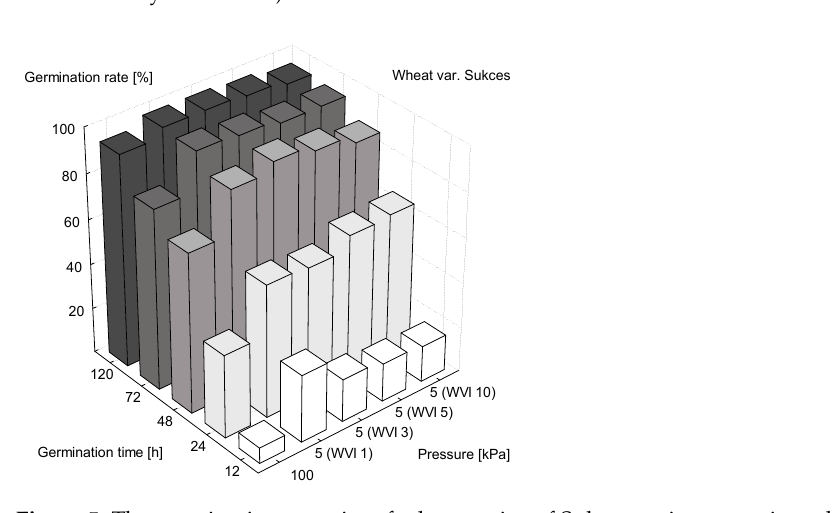
Figure 5. The germination capacity of wheat grains of Sukces variety over time, depending on the impregnation method (WVI 1—1 cycle of WVI, WVI 3—3 cycles of WVI, WVI 5—5 cycles of WVI, WVI 10—10 cycles of WVI).